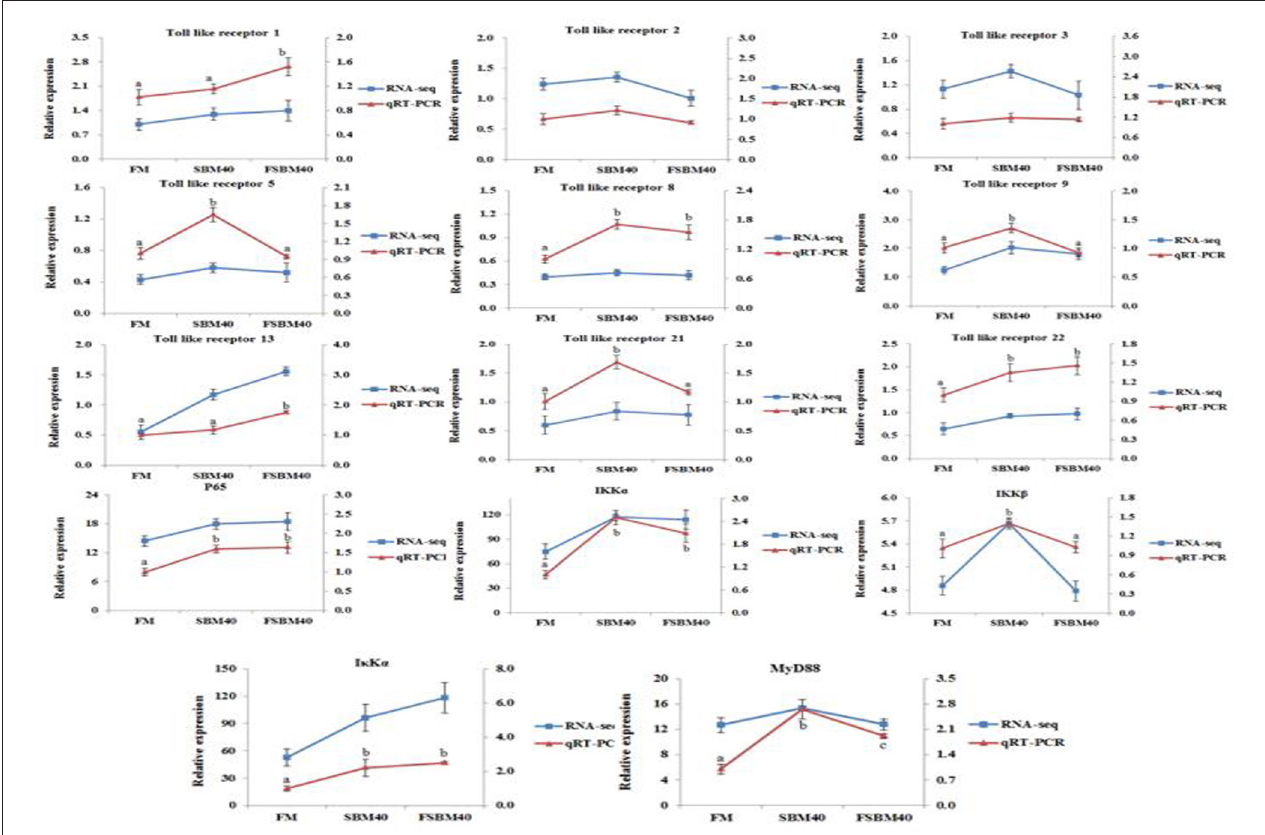
FIGURE 6 | Comparison of RNA Seq and qRT-PCR results ( n = 4). In order to validate RNA-seq data, qRT-PCR was used to detect the gene expression level of TLR-myD88-NF- κ B pathway in DI tissue of pearl gentian grouper. The mRNA expression level of qRT-PCR was normalized by β -actin. The relative expression level in RNA-seq analysis was calculated by FPKM value. The statistical results were expressed as mean ± SD. Different letters assigned to the lines represented significantly differences between the groups at P < 0.05. FM, fish meal control group; FSBM40, 40% FSBM protein replacement level to FM protein; SBM40, 40% SBM protein replacement level to FM